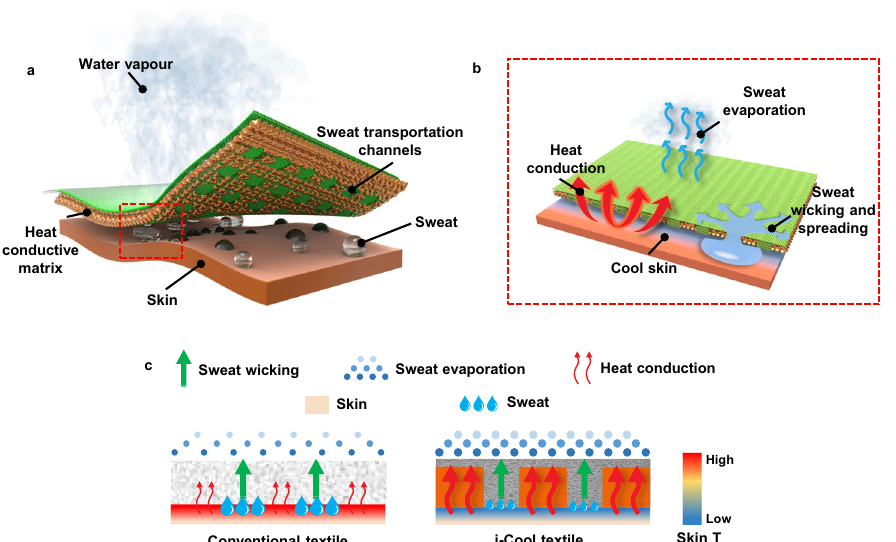
Fig. 1 Schematic of the functional structure design of integrated cooling (i-Cool) textile of heat conduction and sweat transportation for personal perspiration management and its working mechanism. a , Schematic of the i-Cool textile. The synergistic effect of the heat conductive matrix and sweat transport channels provides a solution to textile in personal perspiration management. b , Schematic of the working mechanism of the i-Cool textile. When human body perspires, the water transport channels can wick sweat from the skin surface and spread sweat onto the large-area top surface made of fi bers quickly. The heat conductive matrix transfers human body heat ef fi ciently to where the evaporation happens, to assist fast evaporation. Meanwhile, it can deliver the evaporative cooling effect to human body skin ef fi ciently. c , Comparison between conventional textiles and the i-Cool textile.